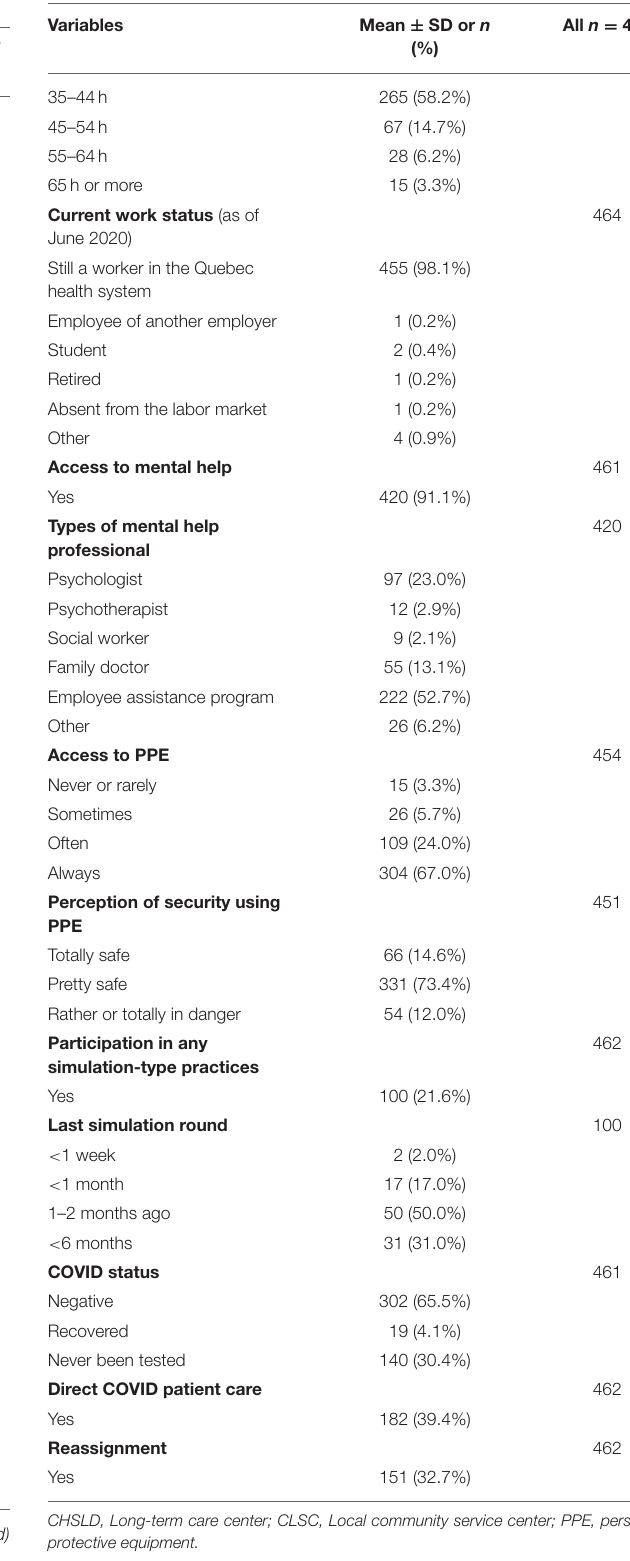
TABLE 1 | Socio-demographic, occupational and COVID-19 specific characteristics of